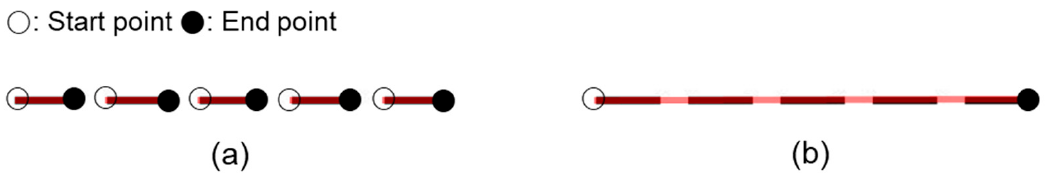
Figure 16. Merging multiple lines of the same type into one line. ( a ) Multiple dotted lines. ( b ) One dotted line after merging.